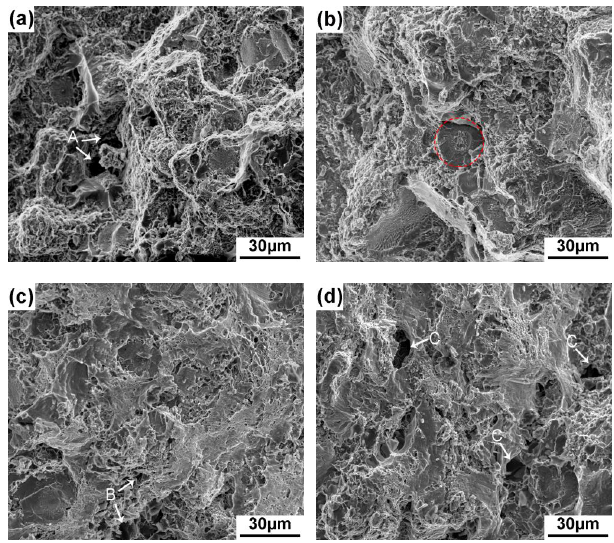
Figure 10. Variations of tensile properties of the composite with mold temperature.